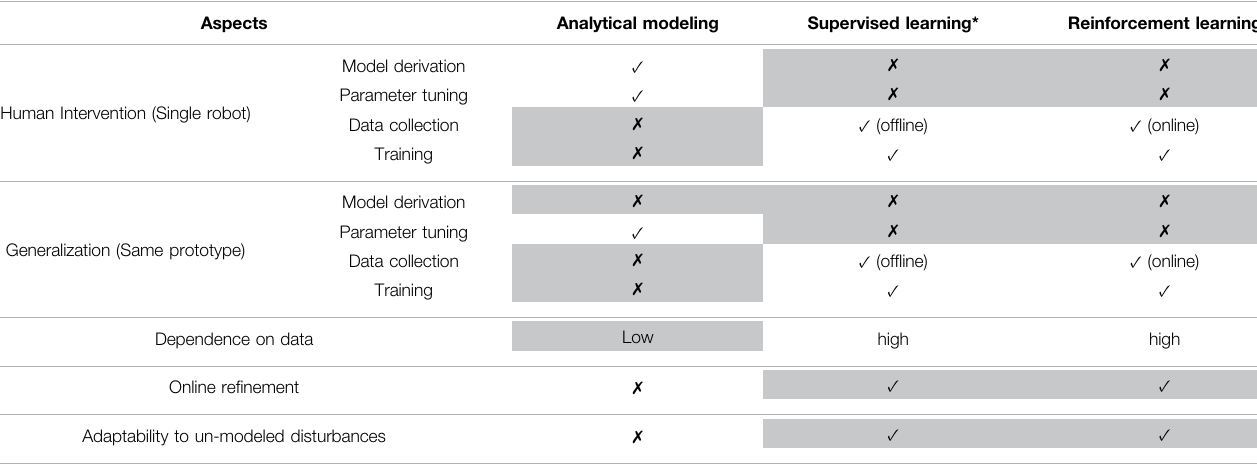
TABLE 3 | A conclusive comparison of analytical-modeling-based and machine-learning-based control.